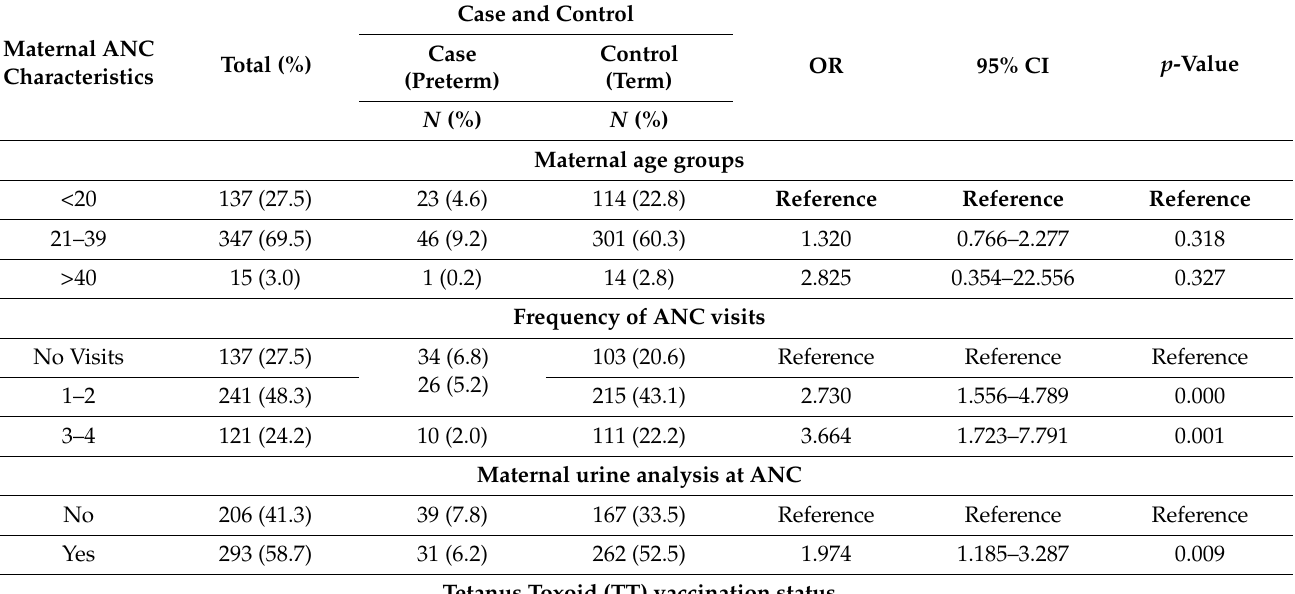
Table 2. Maternal Antenatal care utilization during current pregnancy among women attending four maternal hospitals in Mogadishu,